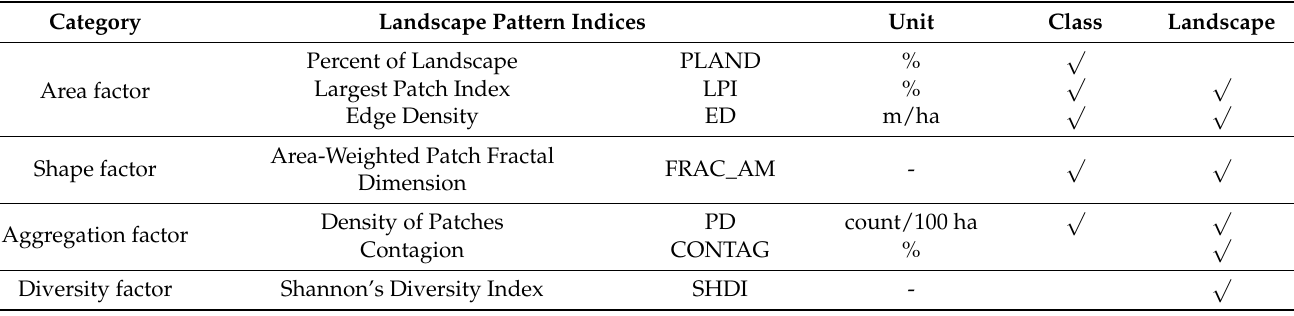
Table 2. Detailed information on landscape